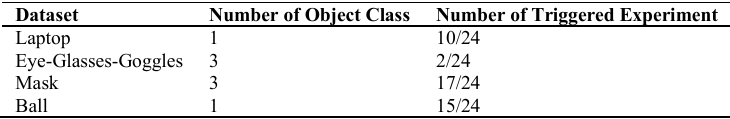
A NALYSIS OF THE EFFECT OF THE NUMBER OF OBJECT CLASSES ON EARLY STOPPING Dataset